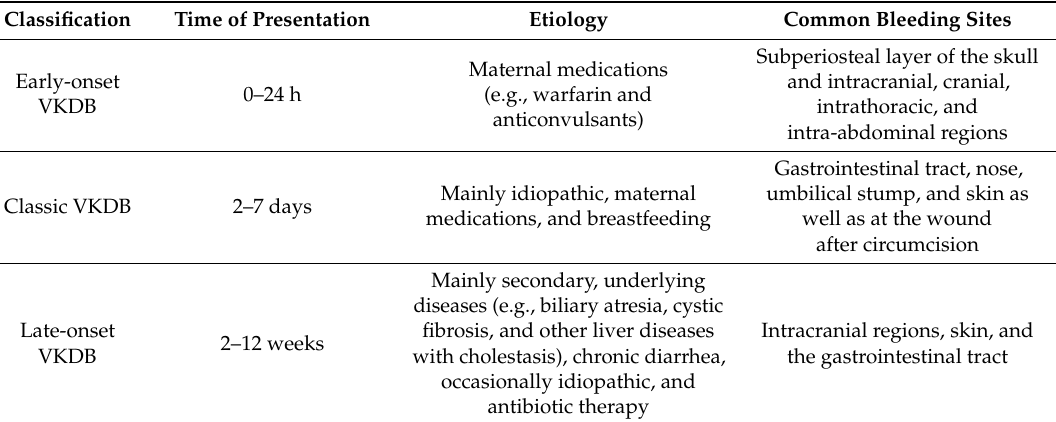
Table 4. Classification of vitamin K deficiency bleeding (VKDB) in